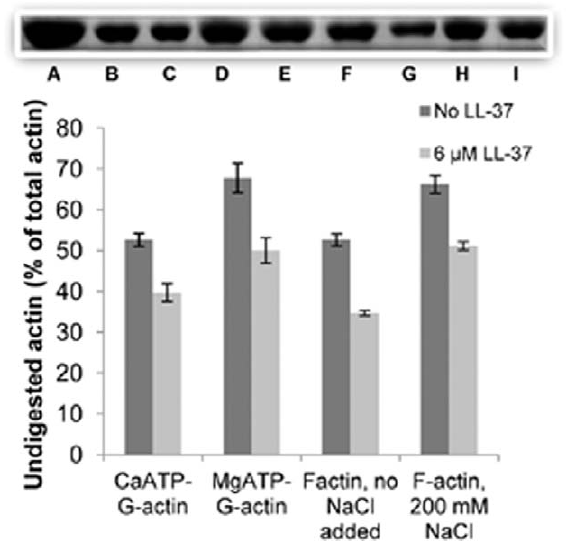
Figure 5. Effect of 6 m M LL-37 on subtilisin digestion of CaATP- G-actin, MgATP-G-actin and Mg-F-actin. 8 m M CaATP-G-actin or 8 m M MgATP-G-actin were digested by 4 m g/ml subtilisin for 2 min, MgF-actin (8 m M) was digested by 20 m g/ml subtilisin for 30 min in the presence or absence of 6 m M LL-37. Digestions were carried out at 22 u C and quenched by 1 mM PMSF. Samples were analyzed by 12% SDS- PAGE and densitometry. Gel insert shows representative actin bands: (A), actin only; (B), CaATP-G-actin, subtilisin, no LL-37; (C), CaATP-G- actin,subtilisin and LL-37, (D) MgATP-G-actin, subtilisin, no LL-37, (E) MgATP-G-actin, subtilisin and LL-37, (F) Mg-F-actin, subtilisin, no LL-37, (G) Mg-F-actin, subtilisin and LL-37, (H) Mg-F-actin, 200 mM NaCl, subtilisin, no LL-37, (I) Mg-F-actin, 200 mM NaCl, subtilisin and LL-37. The presented quantitation data are mean and standard deviation of three independent experiments.